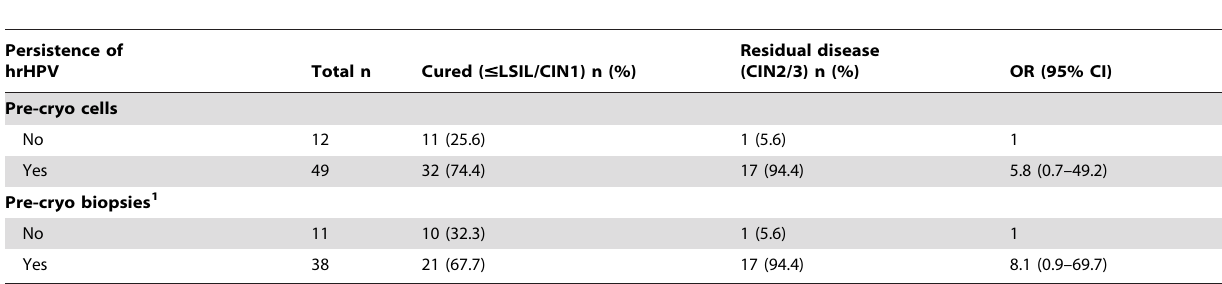
Table 3. Crude odds ratio (OR) and 95% confidence intervals (CI) for residual disease six months after cryotherapy (cryo) for CIN2/3 by persistence of hrHPV infections detected in pre-cryo cells or